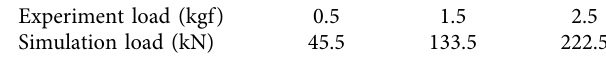
Table 4: Experiment and simulation parameters